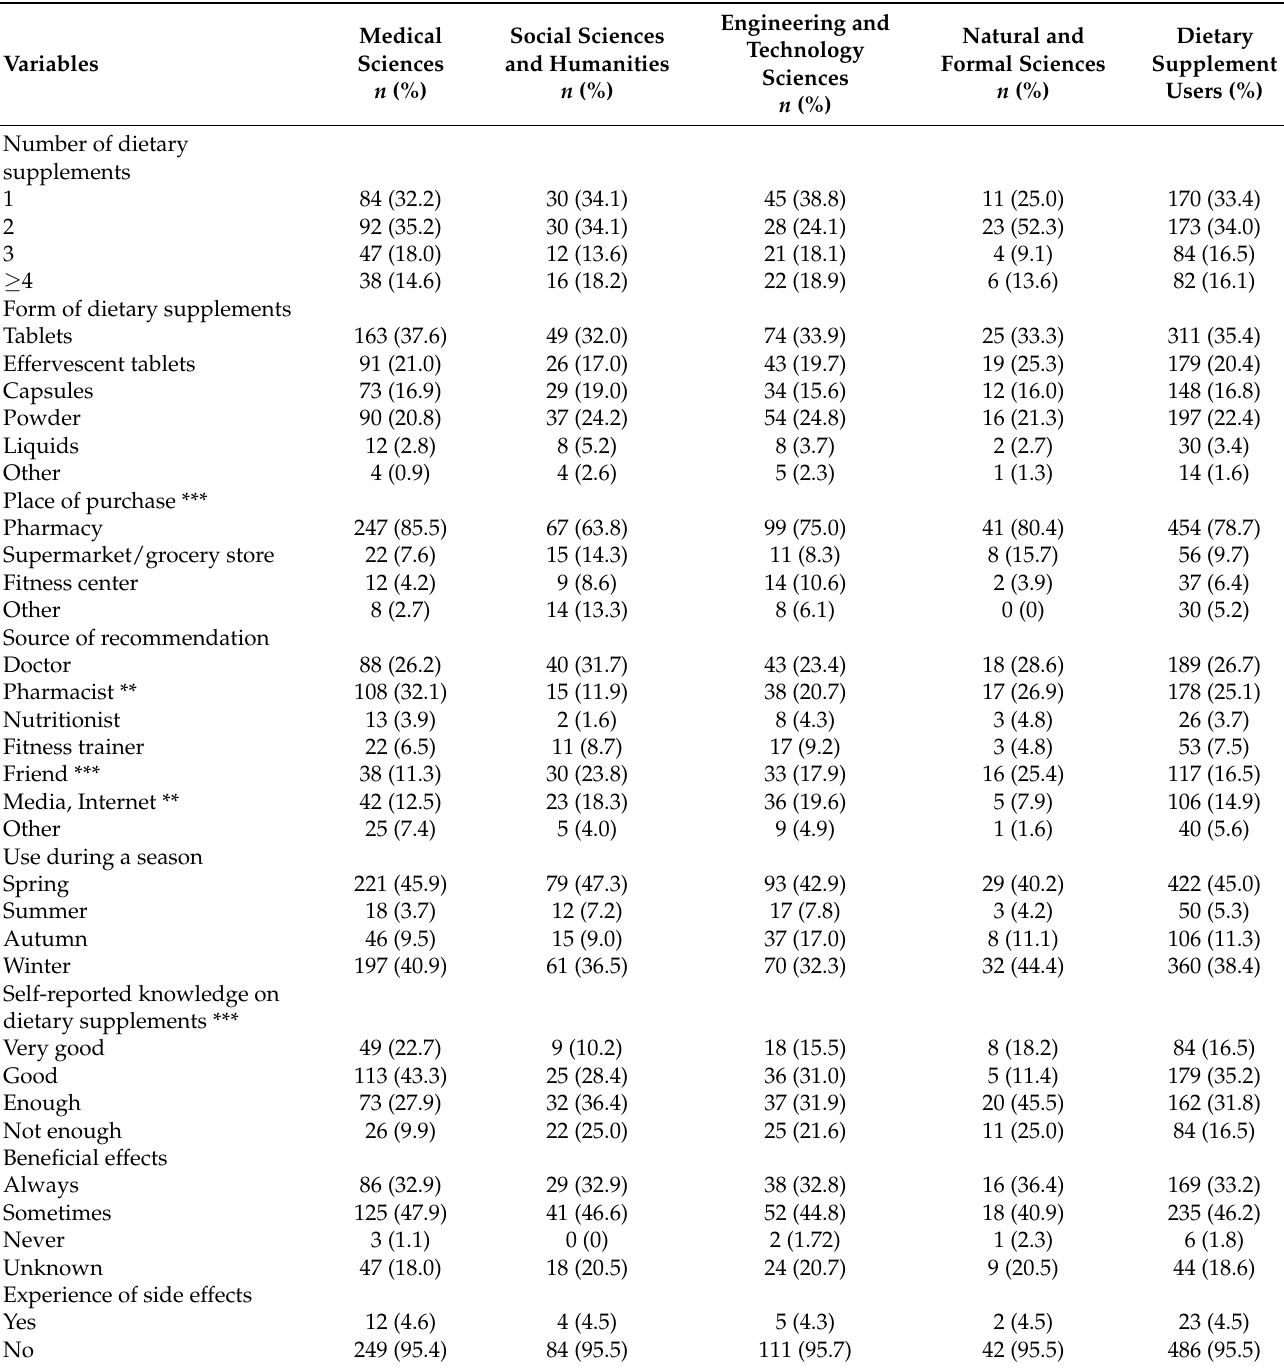
Table 5. Practice and students’ knowledge related to dietary supplements